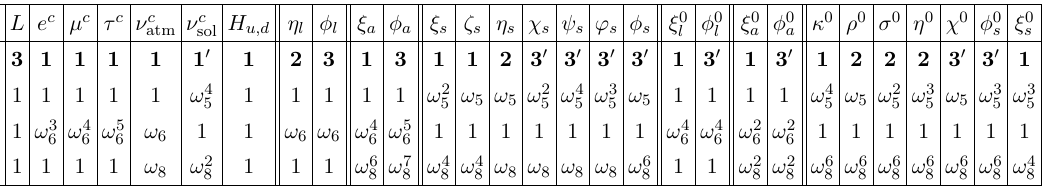
Table 2 . Fields and their transformation properties under the (cid:13)avor symmetry S 4 (cid:2) Z 5 (cid:2) Z 6 (cid:2) Z 8 , where the phases are ! 5 = e 2 (cid:25)i= 5 , ! 6 = e (cid:25)i= 3 and ! 8 = e (cid:25)i= 4 .